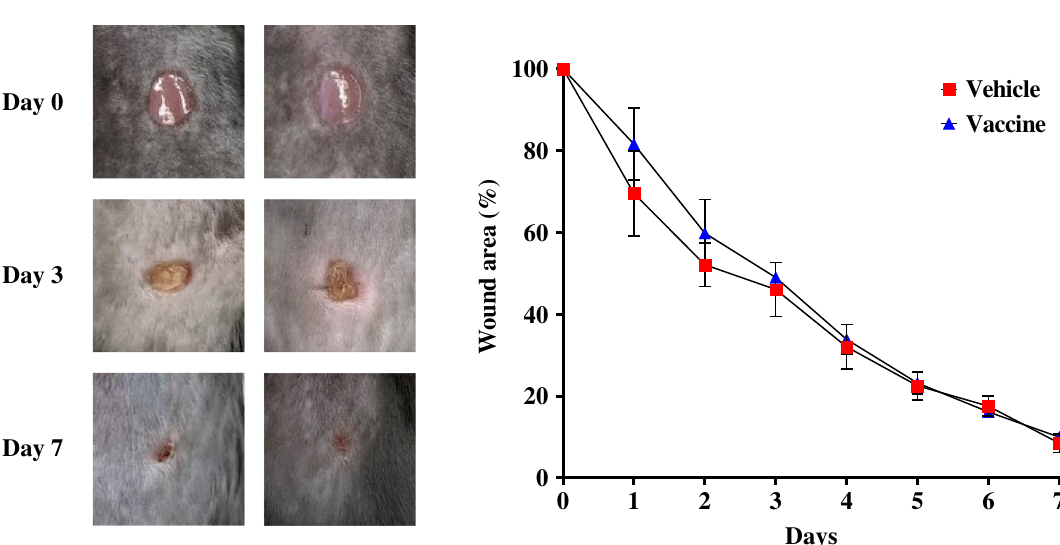
Figure 6. Safety assessment of the CTGF vaccine in the wound healing model. Male C57BL/6 J mice were inoculated with the KLH vehicle or CTGF vaccine ( n = 5/group). Mice received full-thickness excisional wounds of 5 mm in diameter on their back area. Subsequently, the wound areas were measured daily for 7 days, and the changes in wound area were expressed as the percentage of the original wound areas over time. Error bars show mean ± SEM. Statistical difference between the KLH vehicle and CTGF vaccine groups was determined by using Student’s t-test at each time